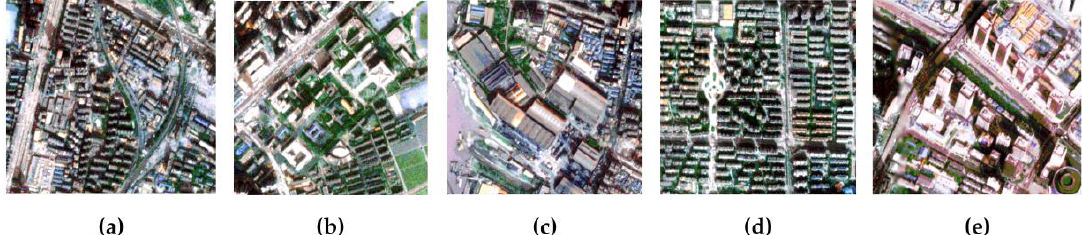
Figure 4. Examples of urban landscape structure and analysis unit types in satellite images: ( a ) commercial and business facilities; ( b ) administration and public services; ( c ) industrial and manufacturing; ( d ) residential land; ( e ) entertainment land.